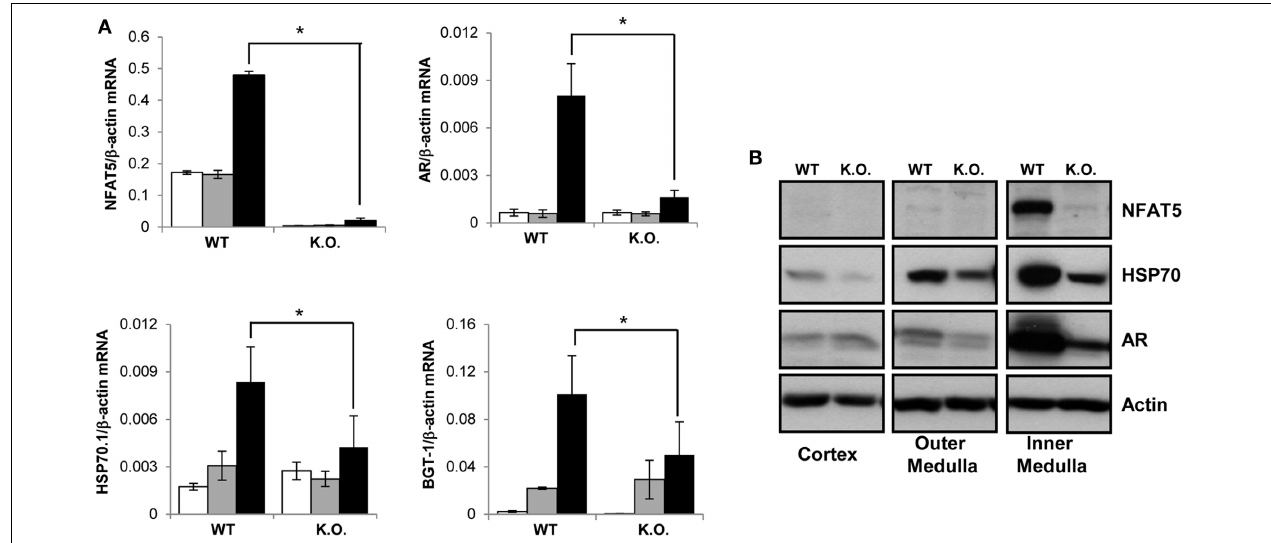
FIGURE 2 | Expression of NFAT5 and NFAT5 target genes in the kidney. Cre + NFAT5 flx / flx mice (or Cre + NFAT5 + / + mice, as control) were fed a tamoxifen-containing diet for 4 weeks to induce Cre -mediated excision of exon 4 of the NFAT5 gene. Subsequently, animals were sacrificed and tissue samples obtained from the renal cortex, outer medulla and inner medulla. (A) mRNA from renal cortex ( (cid:2) ), outer medulla ( (cid:3) ) and inner medulla ( (cid:3) ) was tested for transcription of NFAT5 and NFAT5 target genes AR, BGT-1 and